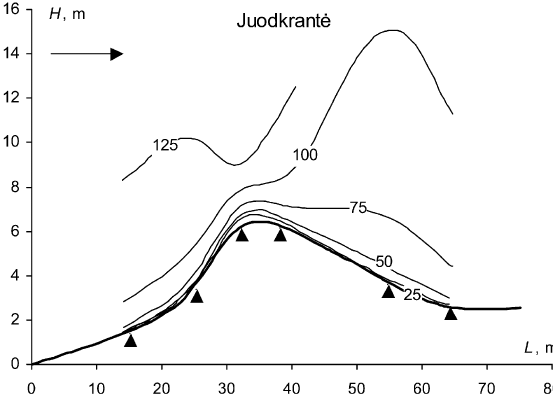
Fig. 6. Variations in wind speed (%) in the cross-shore profile near Pervalka.